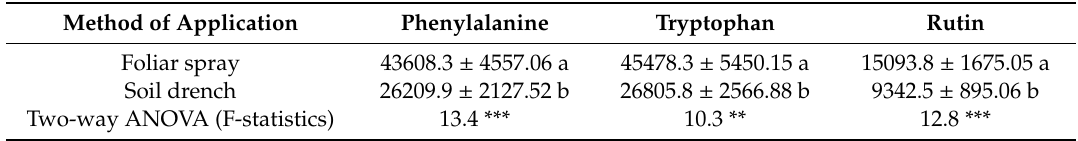
Table 3. Two-way Analysis of Variance on the influence of mode of application on the